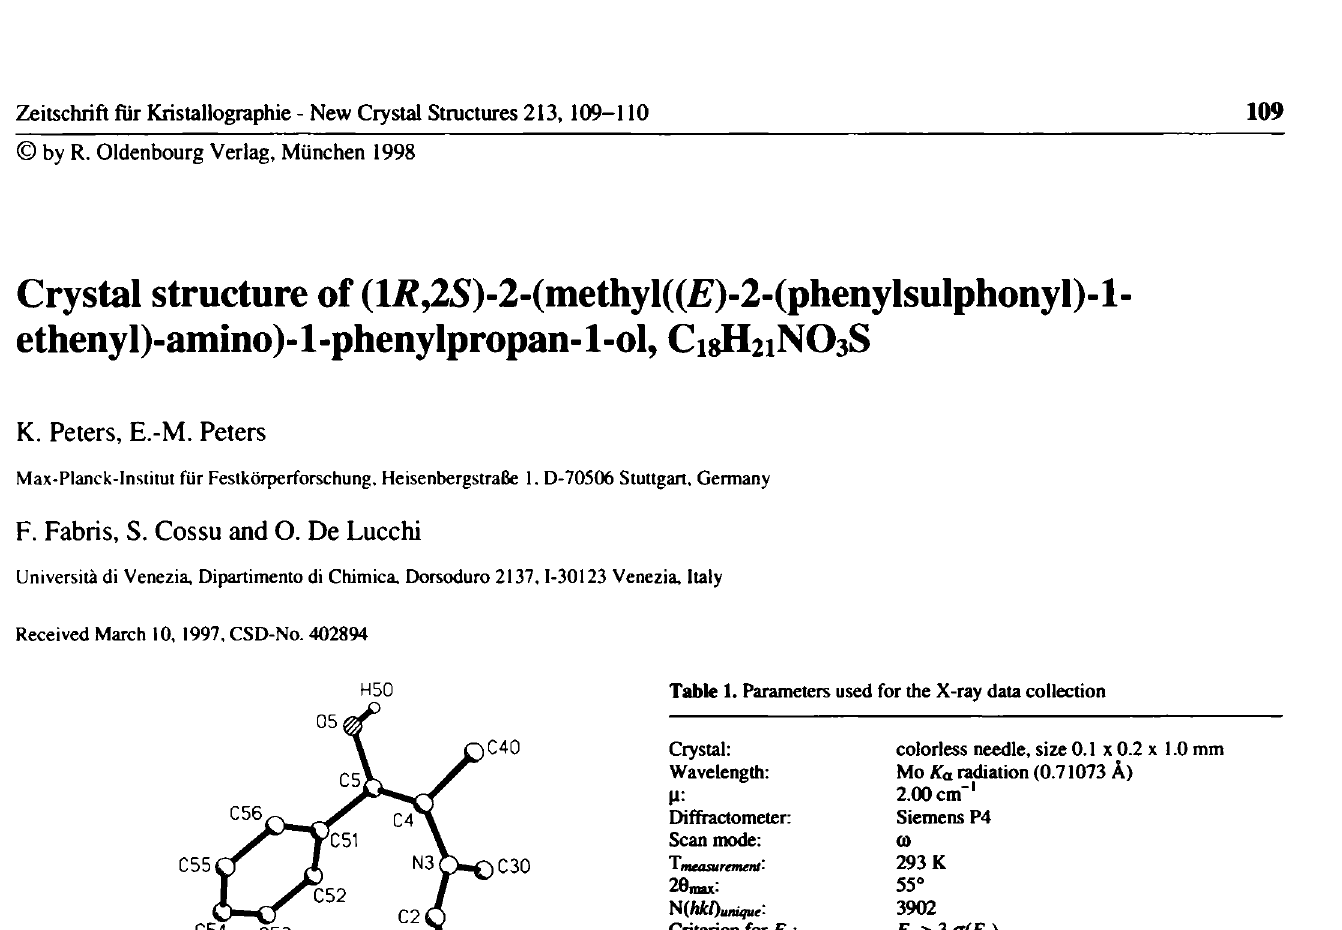
Table 2. Final atomic coordinates and displacement parameters (in